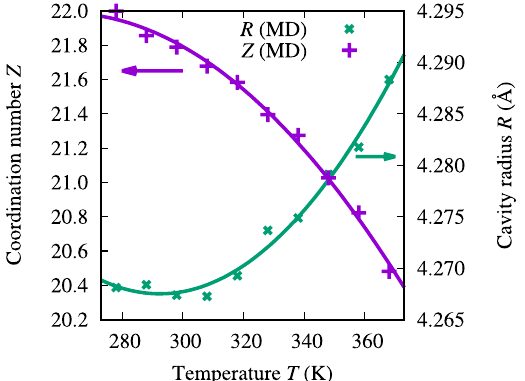
Figure 4. Coordination number Z of the xenon atom and the cavity radius R in the semianalytical cavity model (solid lines), as functions of temperature. MD refers to the Z and R calculated from the MD simulation trajectory as described by Eqs (S18) and (S16) in the Supplementary Information, respectively, along with fitted quadratic polynomials [Eqs (2) and